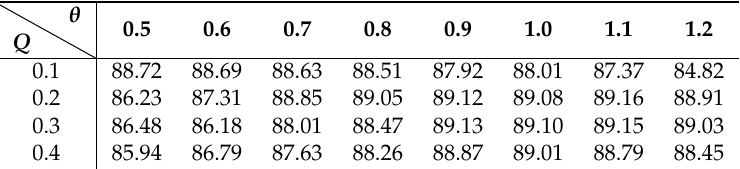
Table 5. Setting parameters for the higher-order term.